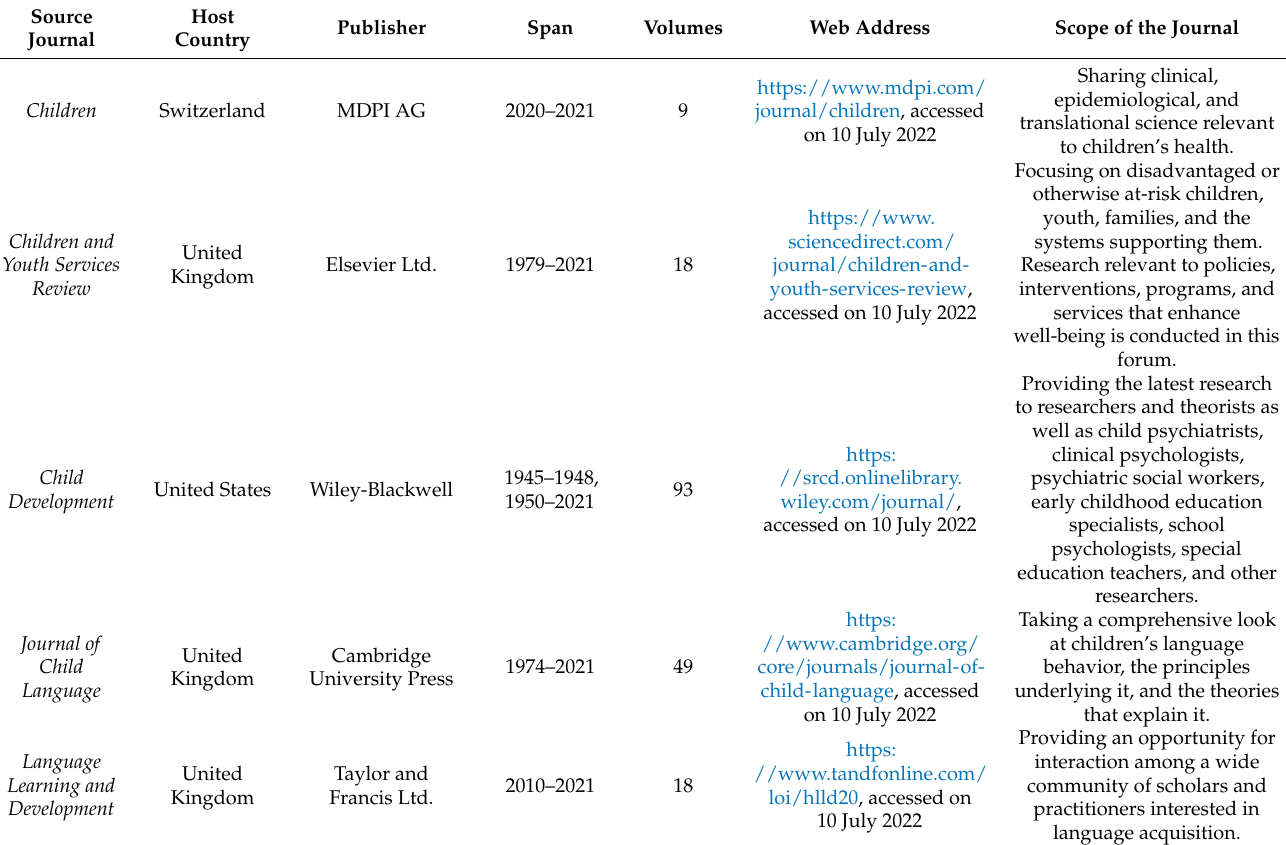
Table 2. Journals publishing research in pragmatic language